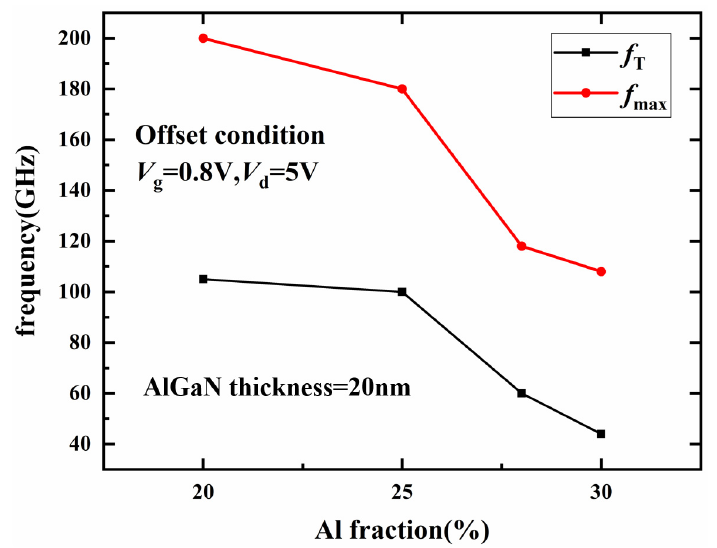
Figure 9. Influence of Al component of barrier layer on f t and f max .